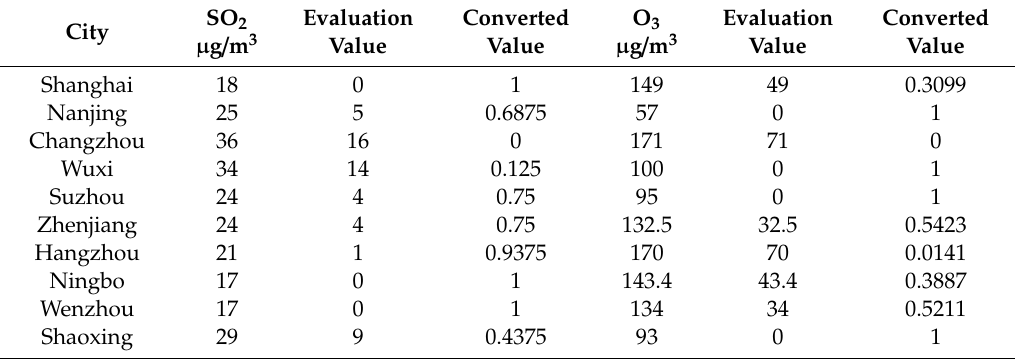
Table 3. The conversion value of air pollution